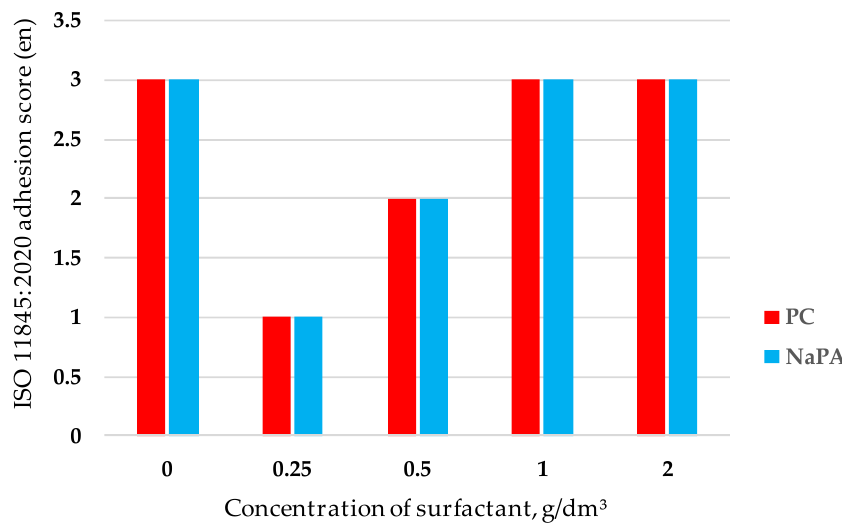
Figure 10. The effect of surfactants on the adhesion of the coating of the studied paints. The effect of surfactants on the corrosion rate in a 10% sulfuric acid solution is shown in Figure 11.